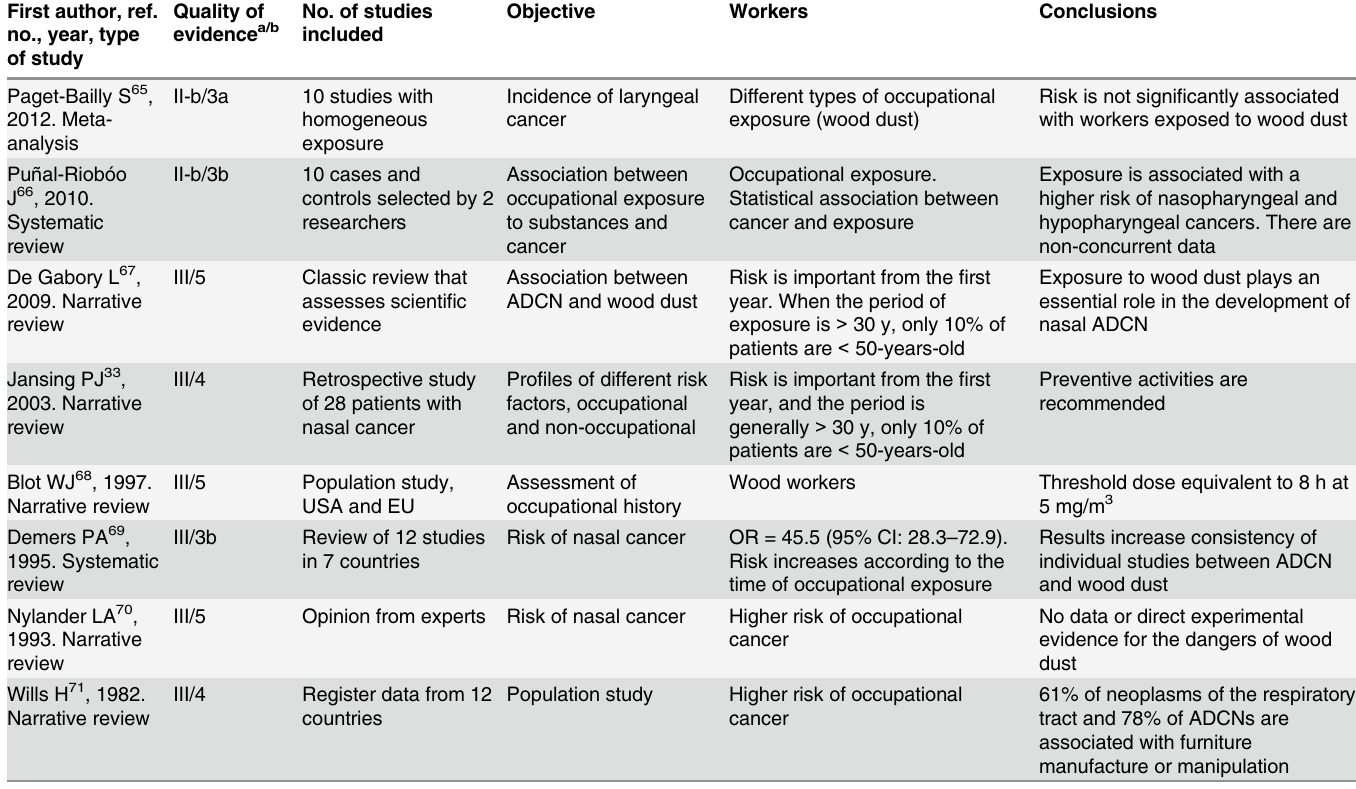
Table 4. Summary of systematic reviews and meta-analyses of exposure to wood